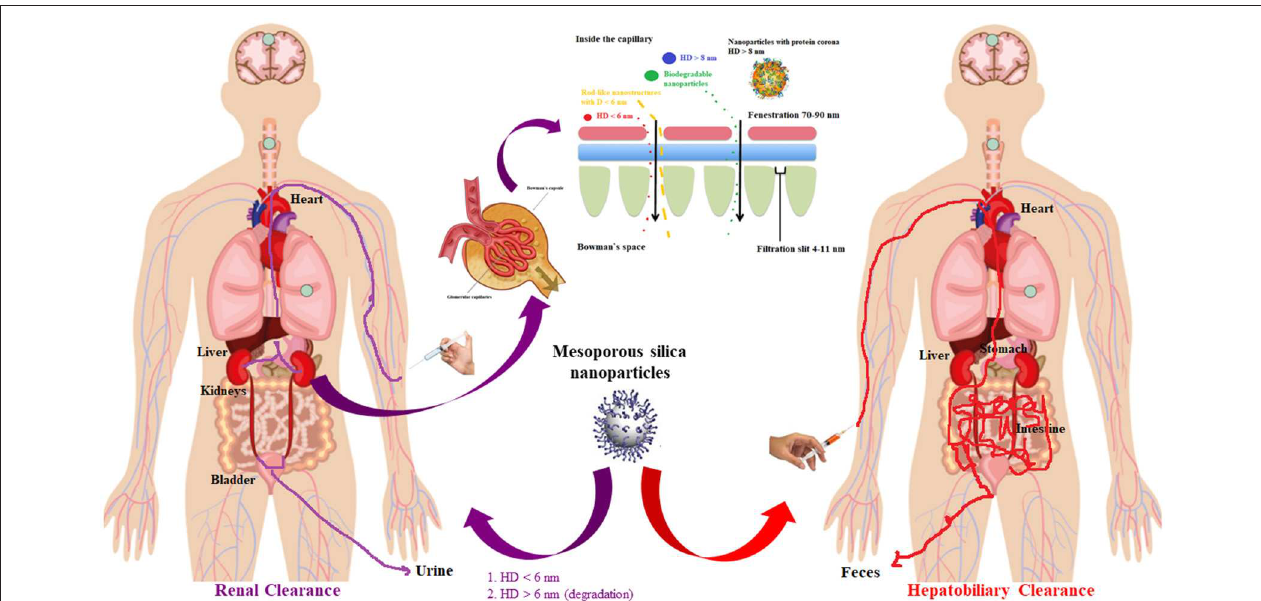
FIGURE 2 | Scheme of the main nanoparticles metabolic path and the glomerular filtration